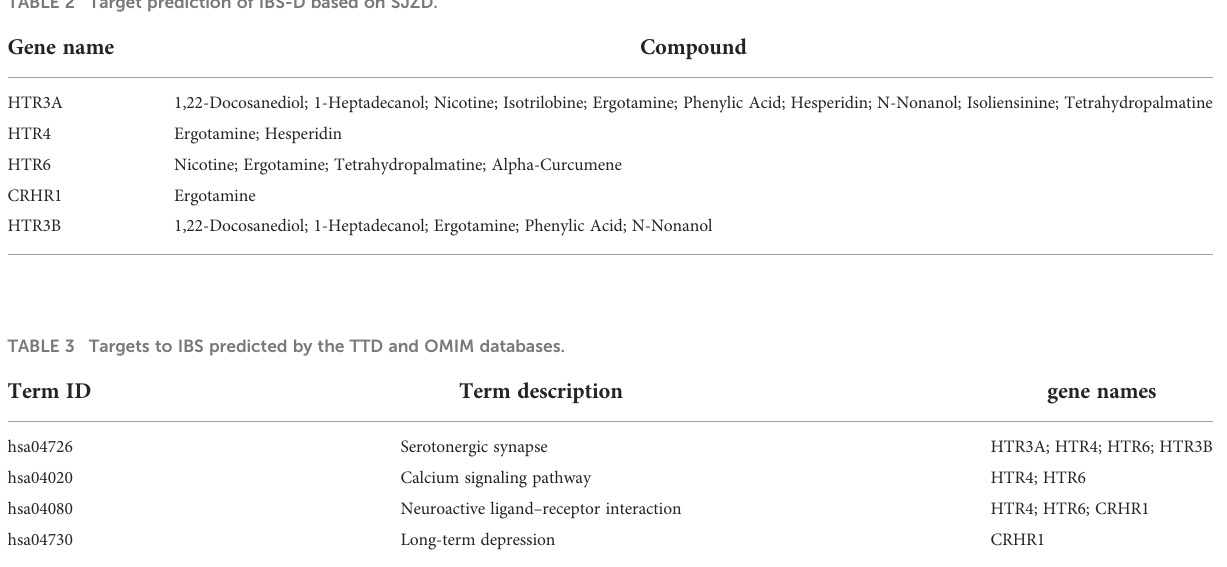
TABLE 2 Target prediction of IBS-D based on SJZD.